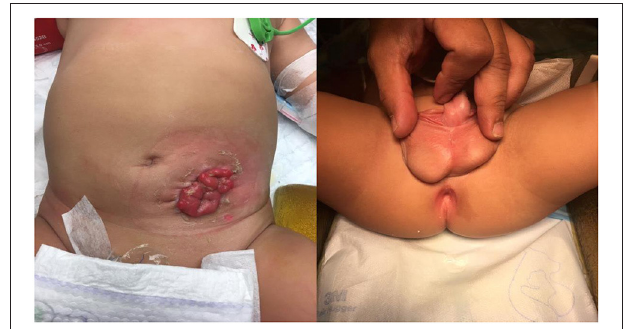
FIGURE 1 | Preoperative photographs of the intermediate anorectal malformation with rectoperineal fistula.